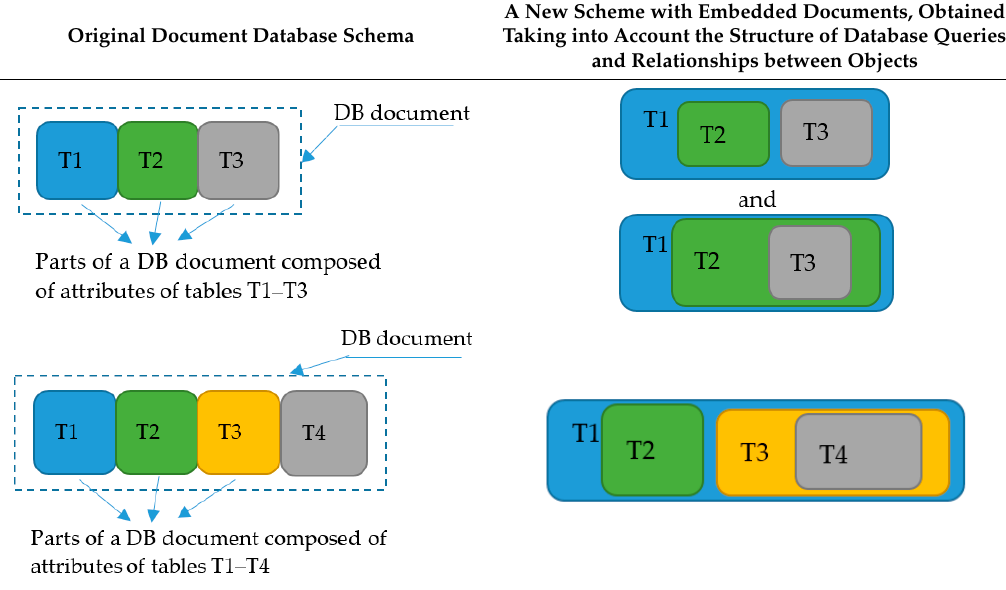
Figure 13. A diagram showing the execution time of six queries to a database of two types: a single database and a database with embedded documents. Table 4. Schematic representation of a document in a document database composed of attributes corresponding to the fields of different tables.